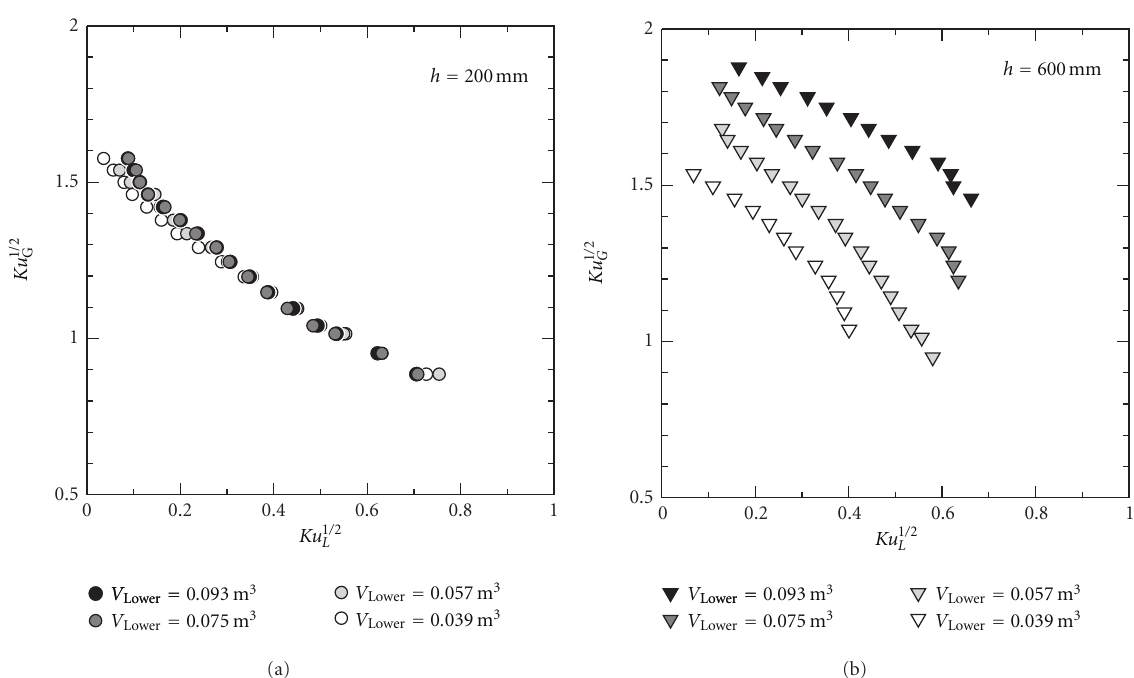
Figure 12: E ff ects of air volume, V Lower , in lower tank on CCFL characteristics ( D =